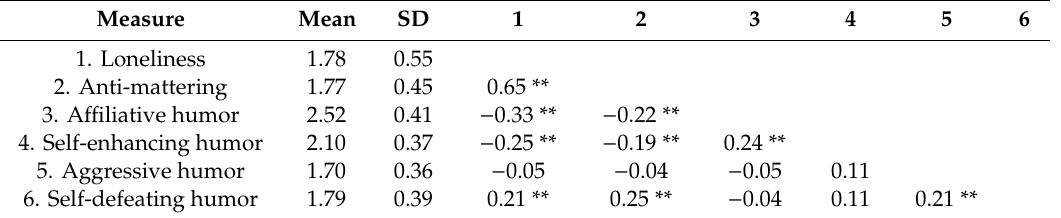
Table 2. Descriptive statistics and inter-scale